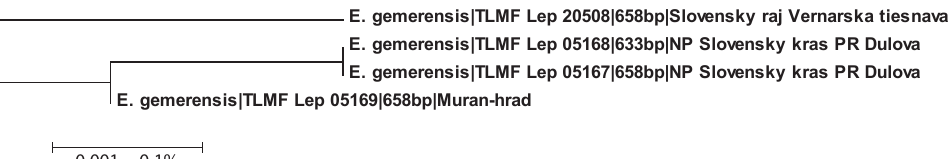
Figure 2. Eulamprotes gemerensis , ♀ genitalia, Gp ZT 12877. Scale bar 1.0 mm.